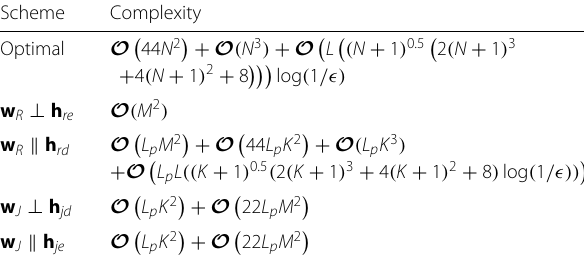
Table 1 Computational complexity of all schemes Scheme Complexity Optimal